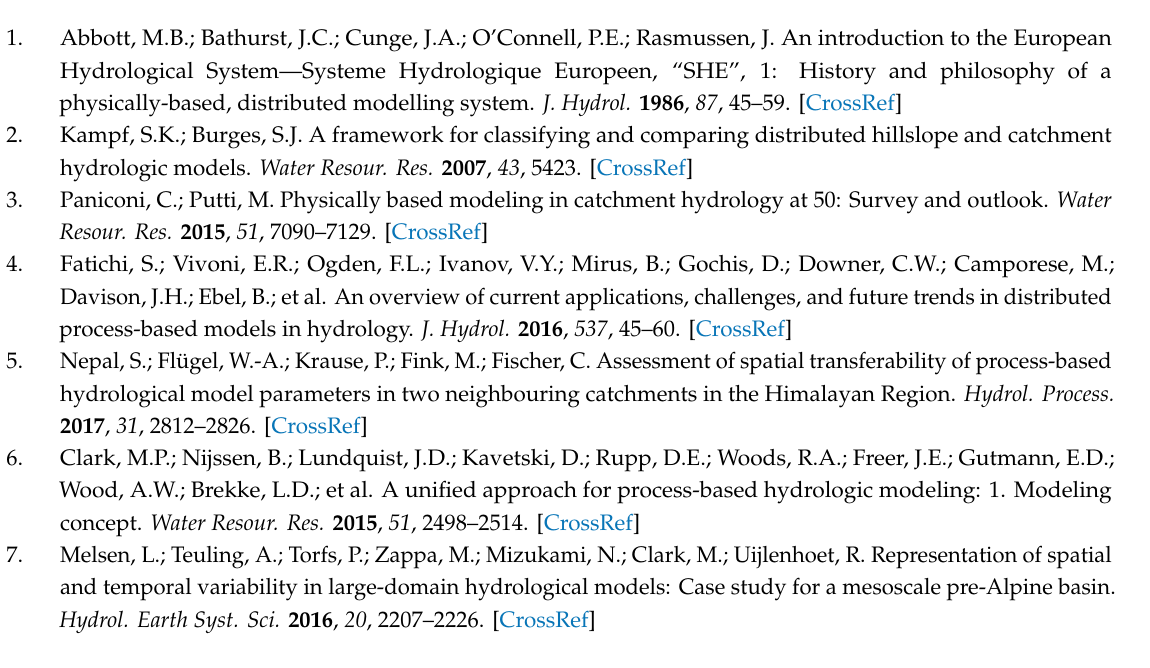
Table S1. Routing parameters for the tRIBS model; Table S2. Routing parameters for the TOPKAPI model; Table S3. Hydraulic geometry parameters for the surface routing module of the CATHY